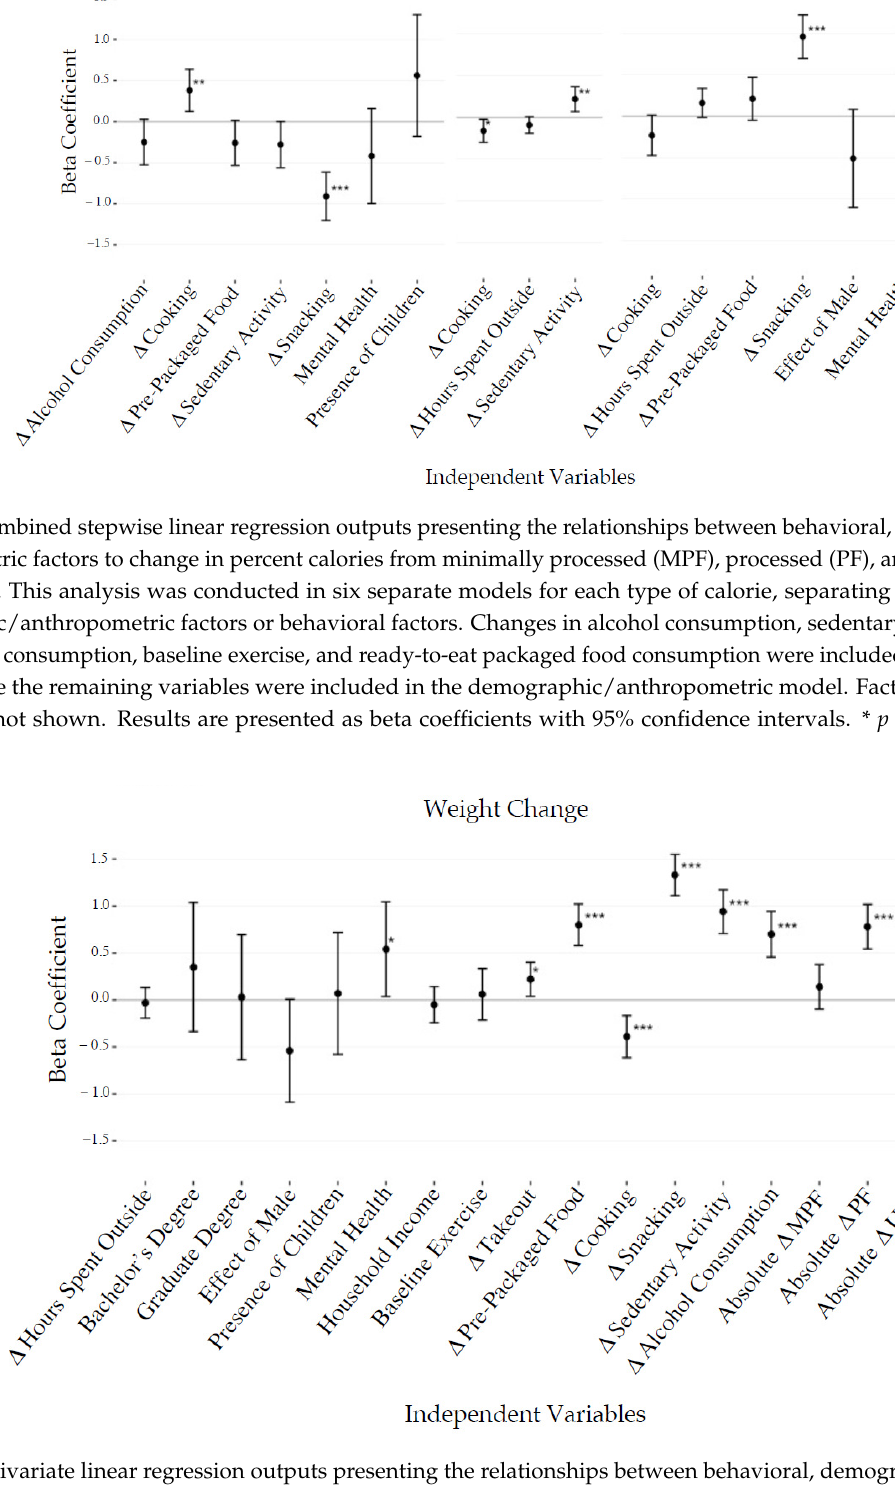
Figure 3. Univariate linear regression outputs presenting the relationships between behavioral, demographic, and anthro- pometric factors to change in weight in kilograms. Results are presented as beta coefficients measured in kg with 95% confidence intervals. * p < 0.05, *** p < 0.001.